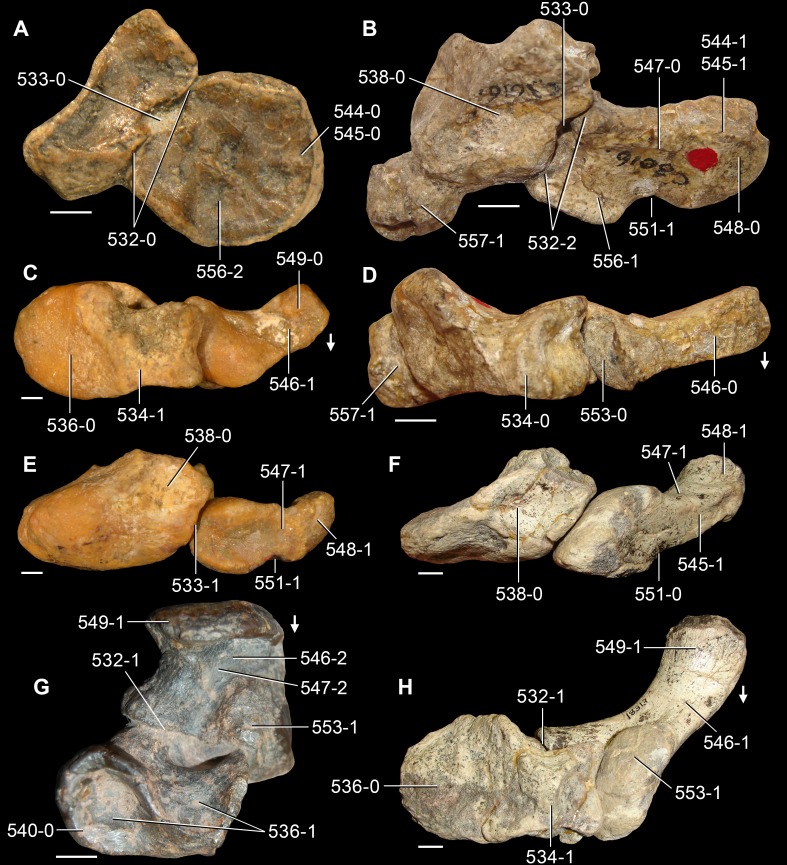
Proximal tarsals of Triassic archosauromorphs in (A, B, E, F) anterior/dorsal and (C, D, G, H) proximal views.(A) Macrocnemus bassanii (PIMUZ T4822); (B, D) Proterosuchus alexanderi (NMQR 1484); (C, E) Euparkeria capensis (UMZC T692); (F, H) Smilosuchus gregorii (USNM 18313); and (G) Aetosauroides scagliai (PVL 2052). Numbers indicate character-states scored in the data matrix and the arrows indicate anterior direction. Scale bars equal 1mm (A, C, E), 5 mm (B, D), and 1 cm (F–H).